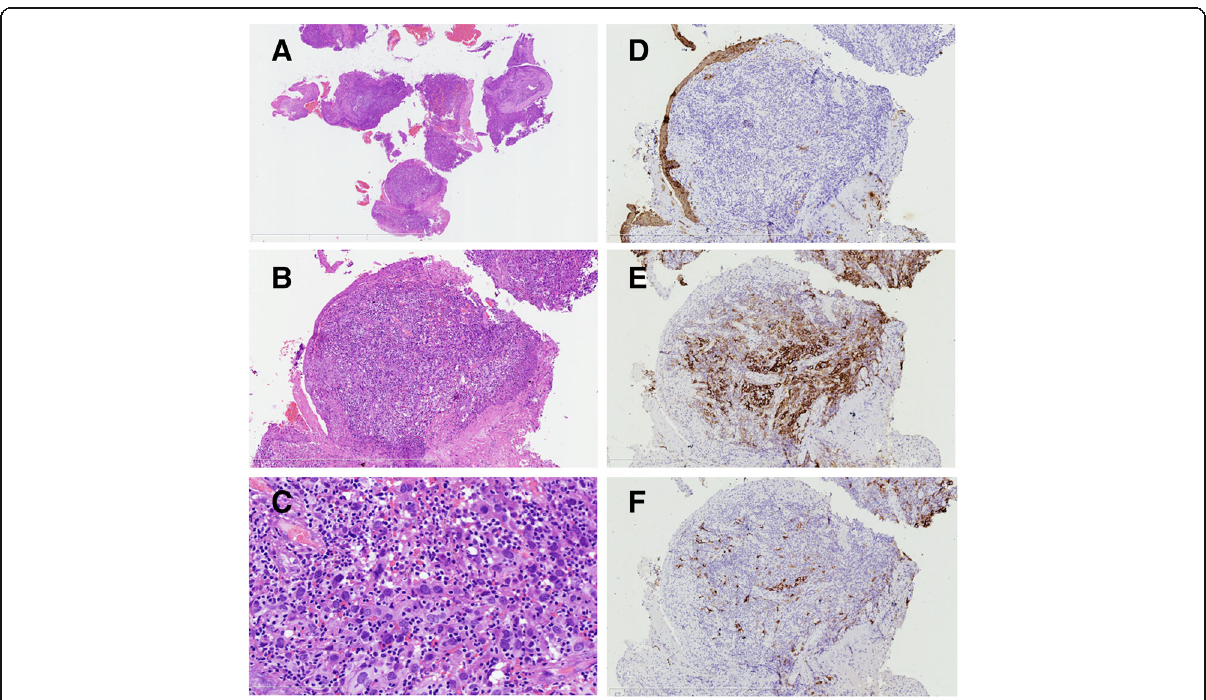
Fig. 4 A low-power view of the tumor tissue by bronchoscopy and biopsy ( a ), metastatic tumor cells are beneath the respiratory epithelium of the trachea ( b ), A high-power view shows round and polygonal tumor cells with sprinkled small lymphocytes infiltration ( c ), similar to those occurring in the bladder. Immunohistochemically, the tumor cells are negative for CK ( d ), positive for CD21 ( e ) and focal positive for CD23 ( f